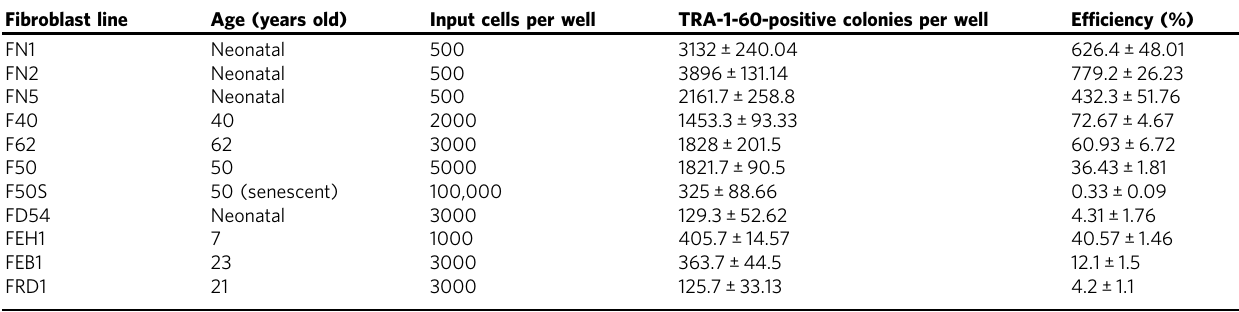
Primary neonatal fi broblast lines: FN1, FN2, and FN5 Healthy primary adult fi broblast lines: F40, F62, and F50 A senescent fi broblast line derived from F50: F50S Disease-associated fi broblast lines: Down syndrome (FD54), epidermolytic ichthyosis (FEH1), epidermolysis bullosa simplex (FEB1), and recessive dystrophic epidermolysis bullosa (FRD1) Values are reported as mean±s.d. ( n = 3) iPSC Induced pluripotent stem